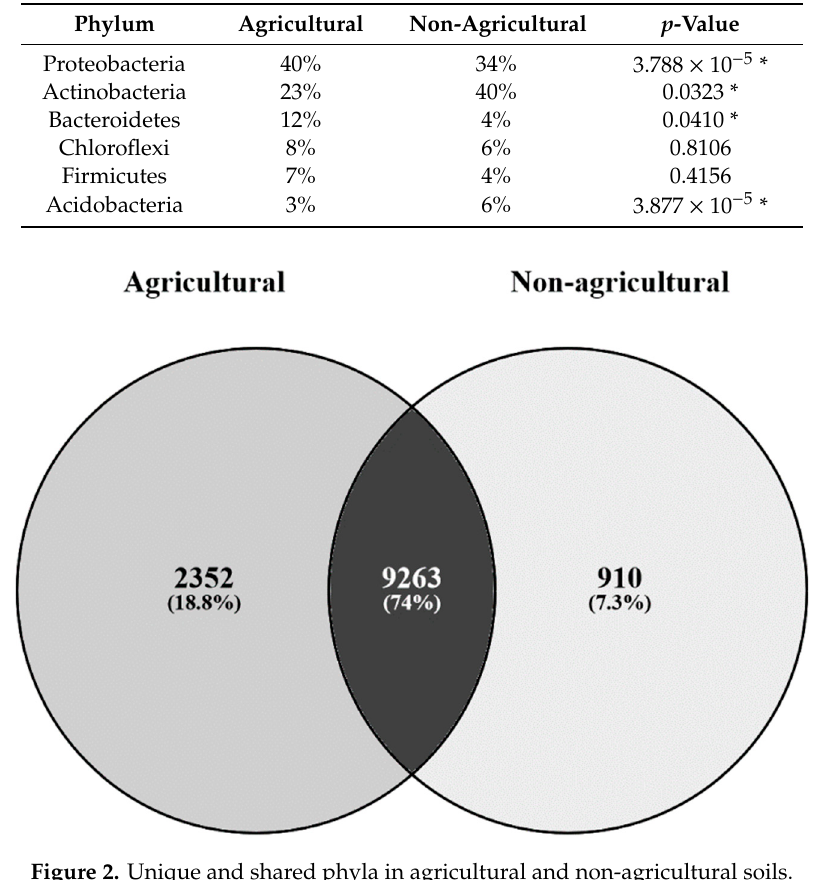
Figure 2. Unique and shared phyla in agricultural and non-agricultural soils.